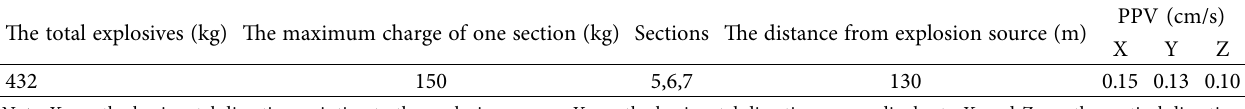
Table 4: Field monitoring data of blasting vibrations.